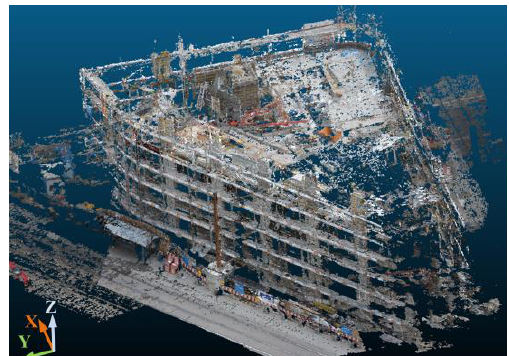
Figure 11. The dense point cloud generated from the images. The point cloud of scaffolding components is detected and extracted using the method described in (Xu et al., 2015), which is shown in Figures 12a and 12b. Here, the red points represent the points of the building surface, while the blue and green points stand for the points of scaffolding